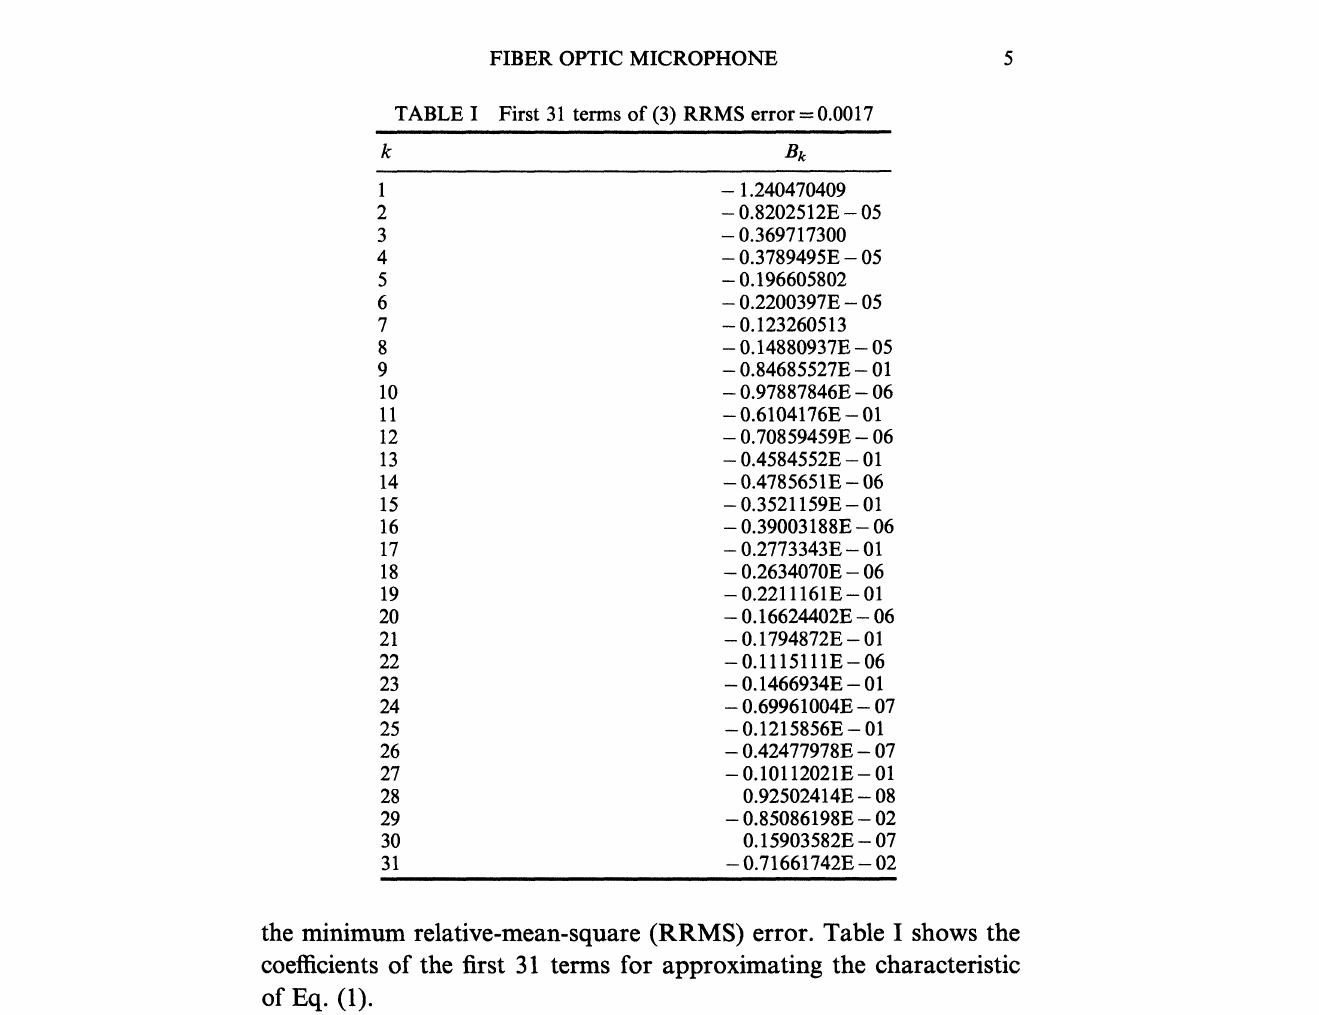
First 31 terms of (3) RRMS